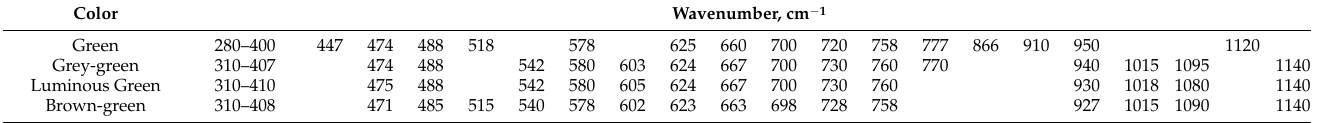
Q-1 (white rock sample) is composed totally of anorthite. Table A2. Infrared absorption bands for the representative Dushan jade